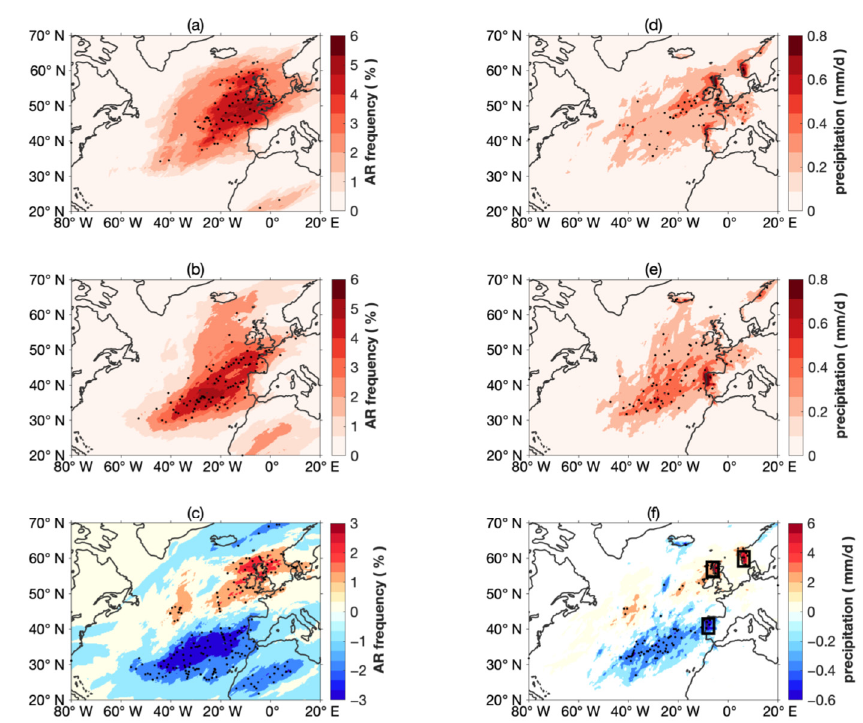
Figure 5. ( a ) Distribution of AR landfalling frequency in NAT+ phase. ( b ) AR landfalling frequency in NAT − phase. ( c ) Difference: black dots mark the difference above 95% confidence level based on a Student’s t -test. Right column( d – f ) is the same as the left but for AR-related precipitation (mm/d). Black boxes in ( f ) are regions that are averaged to obtain the time series of extreme precipitation in eastern Iberia, northeast England and southeastern Norway.